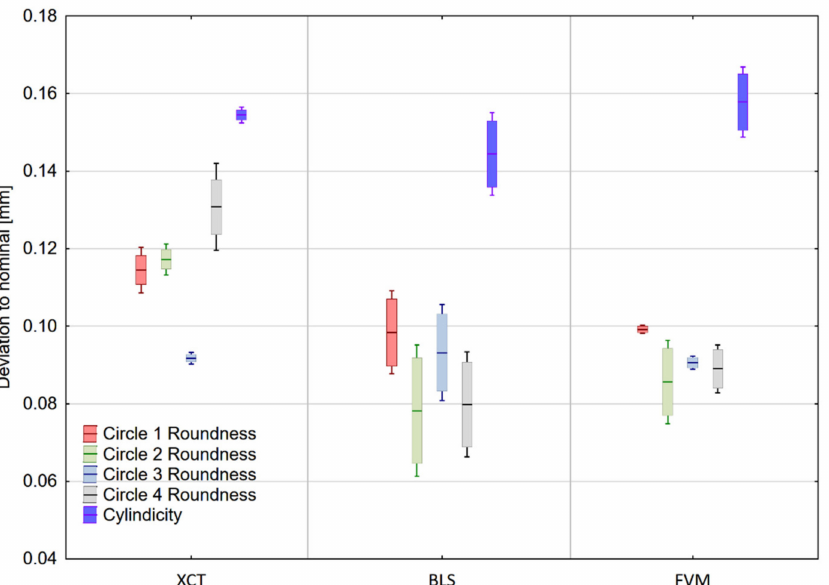
Figure 12. Values of roundness and cylindricity deviation on the measured sample. Corresponding values of different elements are shifted for the purpose of data clarity. Box boundaries are equal to the standard deviation of the measurements, and whiskers represent the 95% Confidence